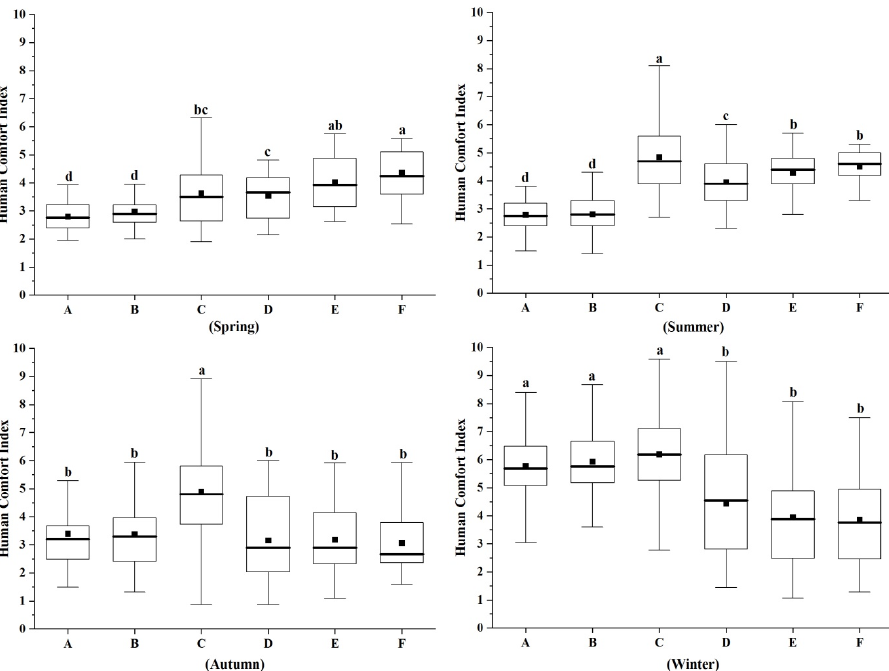
Figure 10. Comparison of the human comfort index in different forest types. A— Phyllostachys edulis forest; B—Subtropical evergreen broad-leaved forest; C—Forestless control group; D— Liquidambar formosana forest; E— Cunninghamia lanceolata forest; F—Coniferous and broad-leaved mixed forest. The different lowercase letters indicate significant difference among the stand types in the same time ( p <